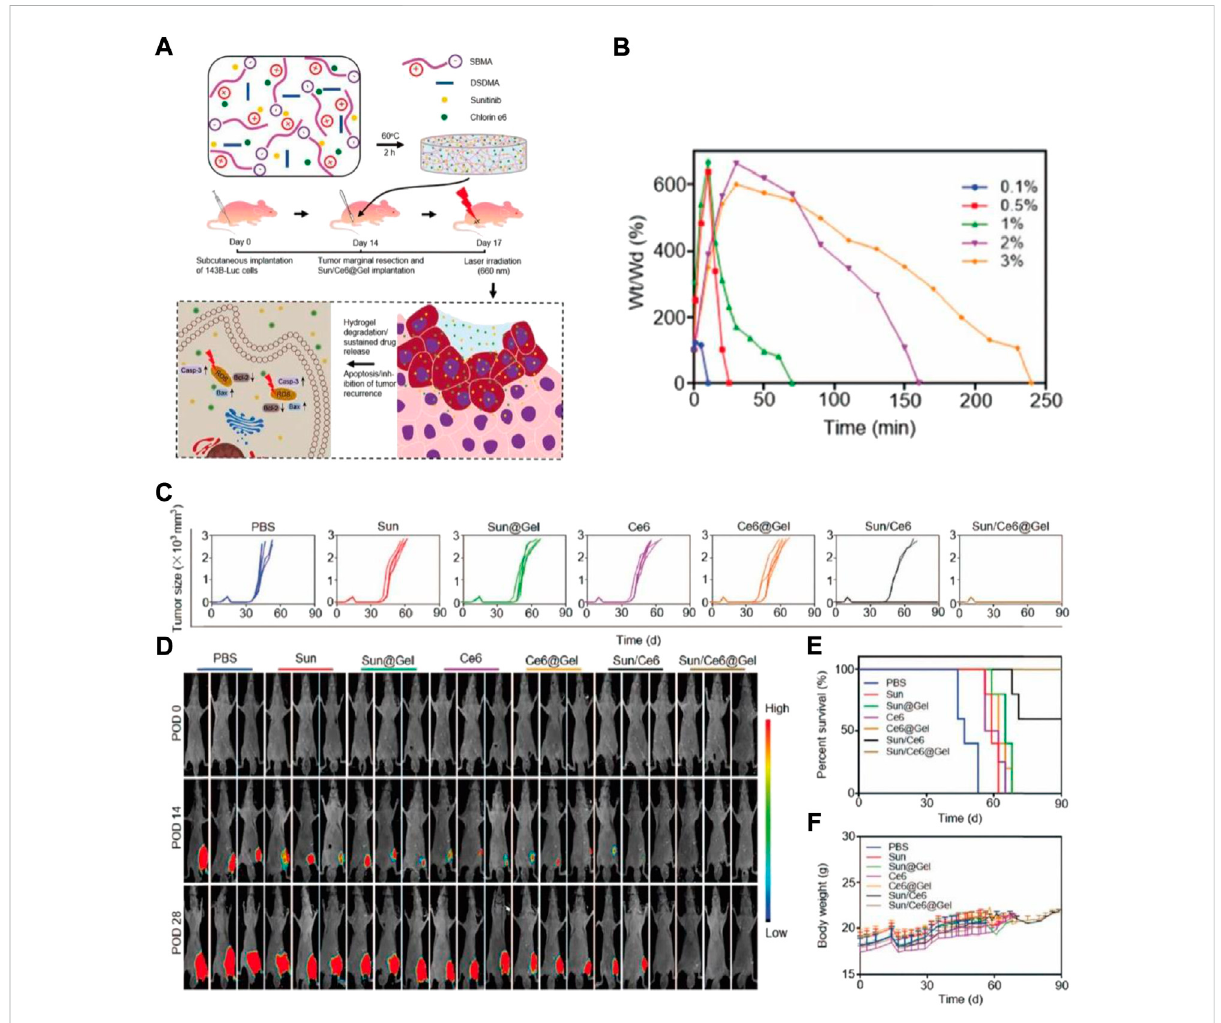
FIGURE 3 (A) Schematic depiction of Sun/Ce6@Gel synthesis and Sun and Ce6 synergistic antitumor impact in inhibiting mice tumor recurrence. Sun/ Ce6@gelwasgeneratedbyfusingCe6,Sun,DSDMA,andSBMAfor2 h,andwasadministeredintheresidualcavity,therebyitinhibitedtumorrelapse post osteosarcoma marginal eradication. Casp-3: caspase-3. The degeneration and DSDMA – SBMA hydrogels release data. (B) Hydrated DSDMA – SBMA hydrogels weight alternations in the solution of PBS supplemented with DTT (100 mM). (C) Individual tumor growth kinetics during the treatment. (D) Invivo nude mice tumor recurrence bioluminescence images. POD, postoperative days. (E) Survival rates (F) Mice ’ s body weights were measured, and the effective doses of Sun and Ce65 were selected as 5mg and 1 mg per kg,